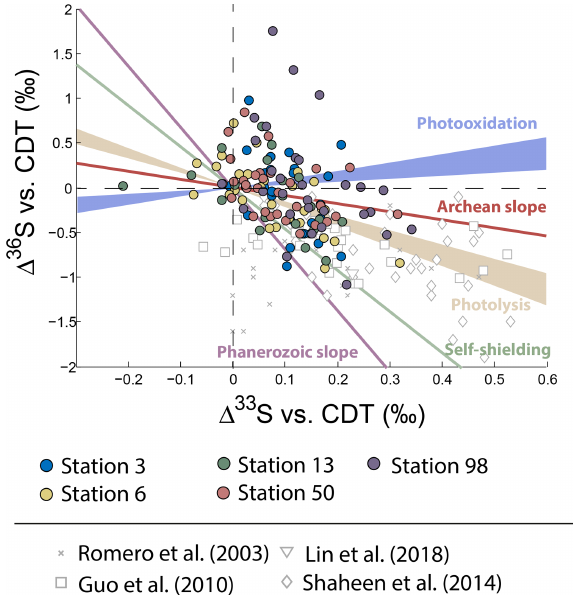
Figure 3. Variations of (cid:49) 33 S as a function of δ 34 S in sulfates from PM 10 aerosols collected in Montreal. Archean and Phanerozoic slopes taken from the literature are also